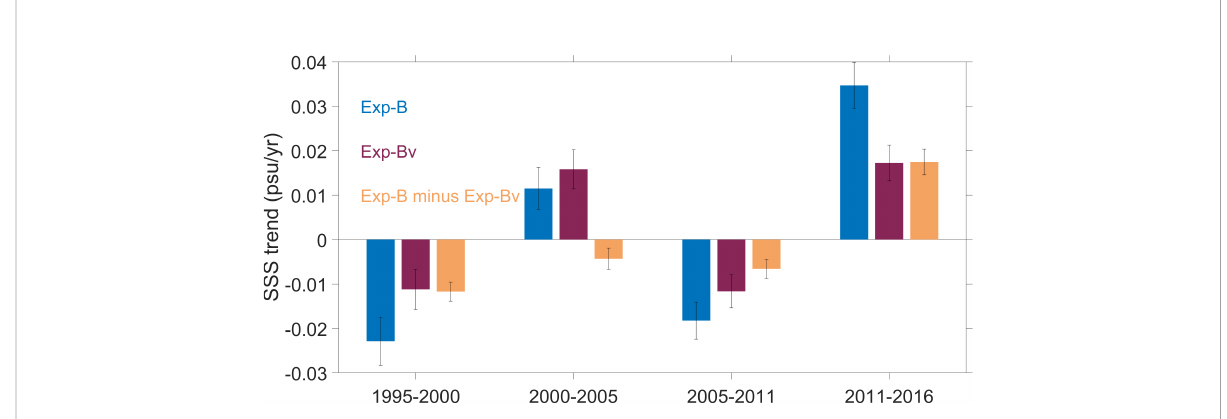
FIGURE 13 Linear trends of SSS in the SEIO for the periods of 1995-2000, 2000-2005, 2005-2011, and 2011-2016 derived from Exp-B (blue), Exp-Bv (purple) and Exp-B minus Exp-Bv (orange). Error-bars denote the 90% con fi dence interval based on an F